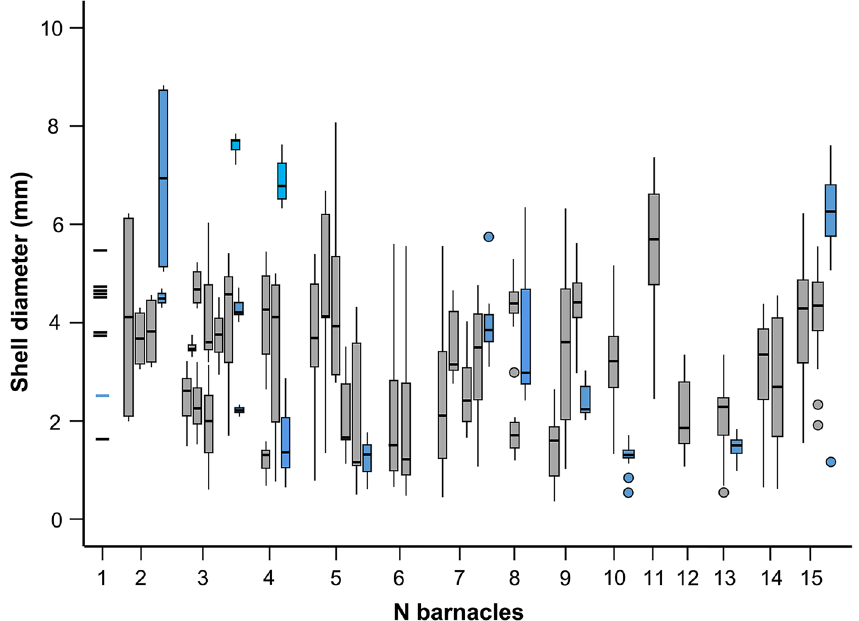
Figure 4. Box-and-whisker plots showing the maximum diameter of the shell of populations of the barnacle Xenobalanus globicipitis on 15 Antartic minke whales, Balaenoptera bonaerensis (blue boxes) from the Southern Ocean and 44 striped dolphins, Stenella coeruleoalba (gray boxes), from the western